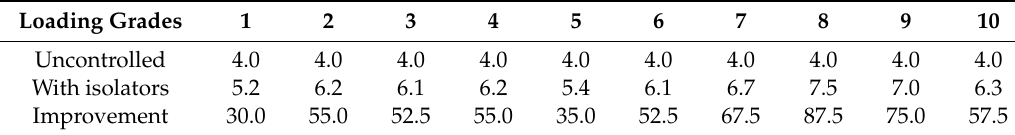
Table 1. Equivalent damping ratio (%).